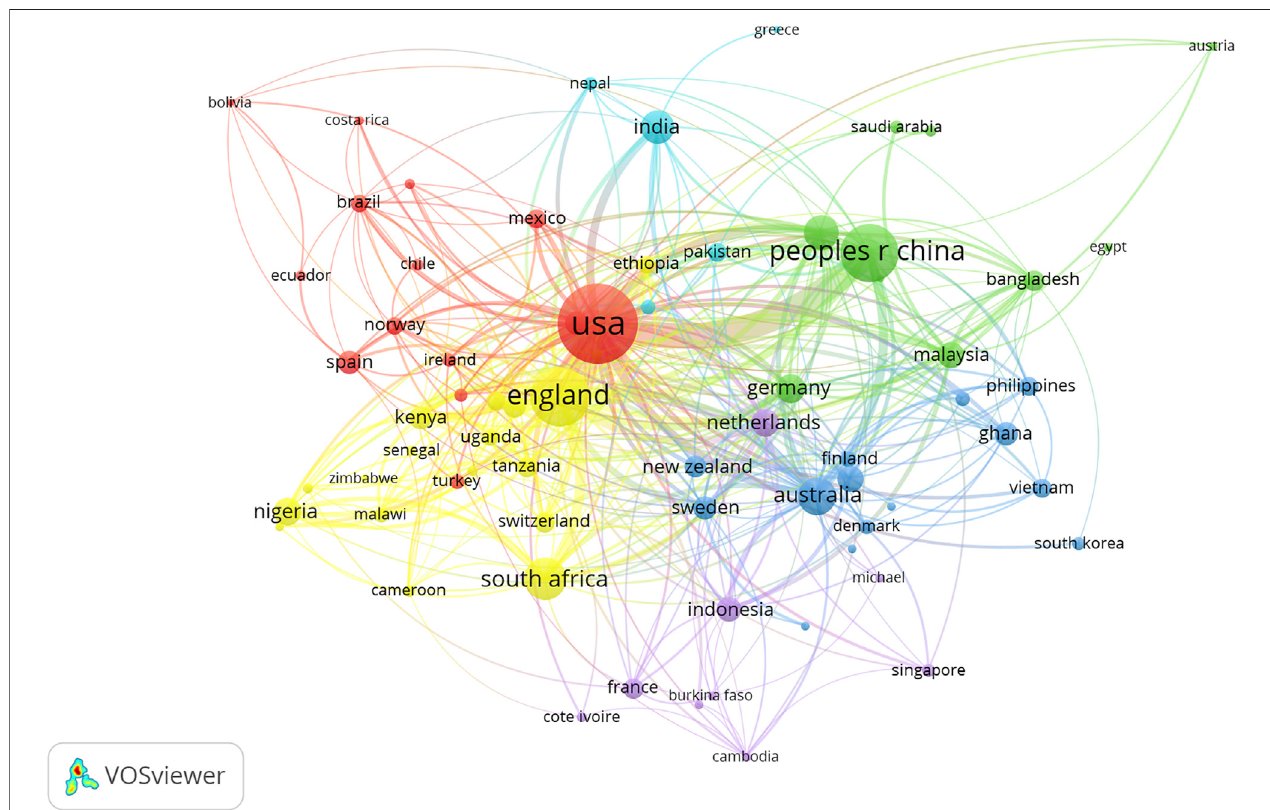
FIGURE 5 | International networks of